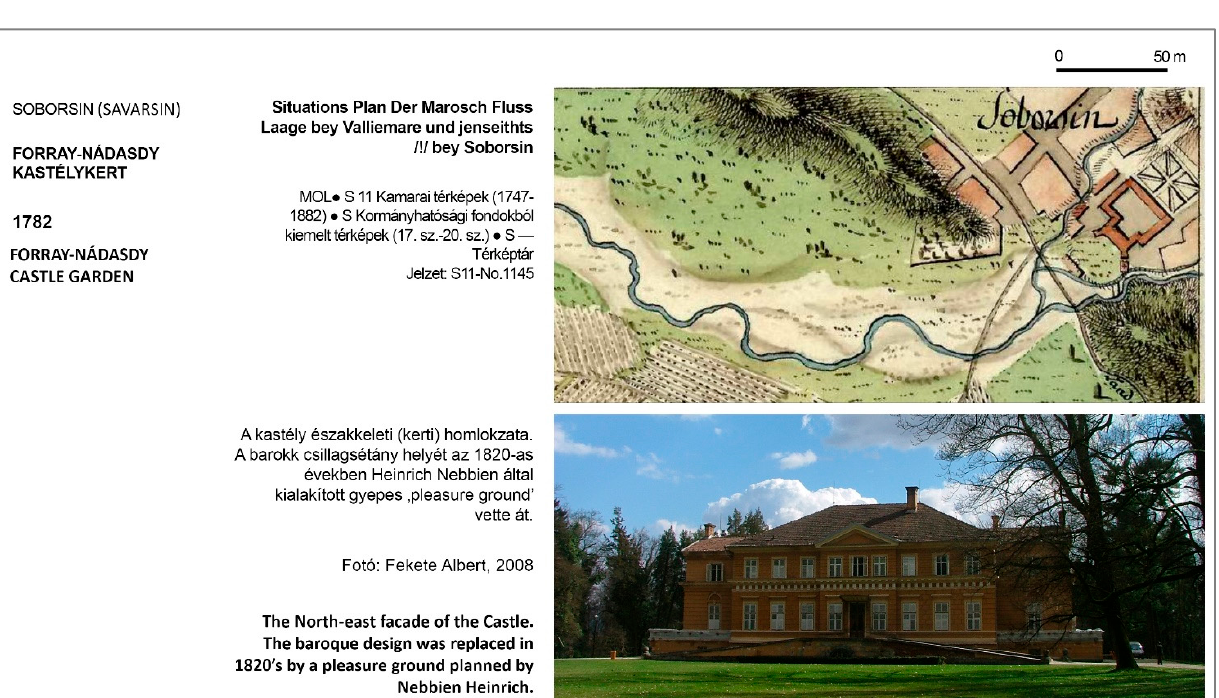
Land 2022 , 11 , x Figure 8. The Forray–Nádasdy Castle and its garden in Soborsin (S ă vâr ş in, RO) in 1782. Figure 8. The Forray–N á dasdy Castle and its garden in Soborsin (S ă v â r¸sin, RO) in 1782.